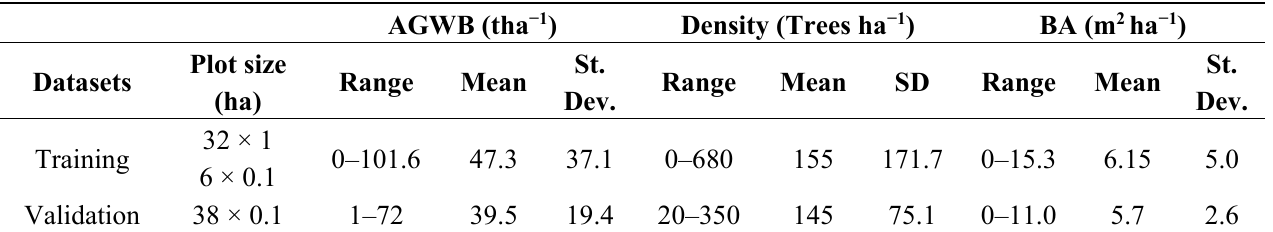
Table 1. Training and external validation AGWB datasets that were used in the non-linear regression fitting and the validation of the WCM; these datasets are described in